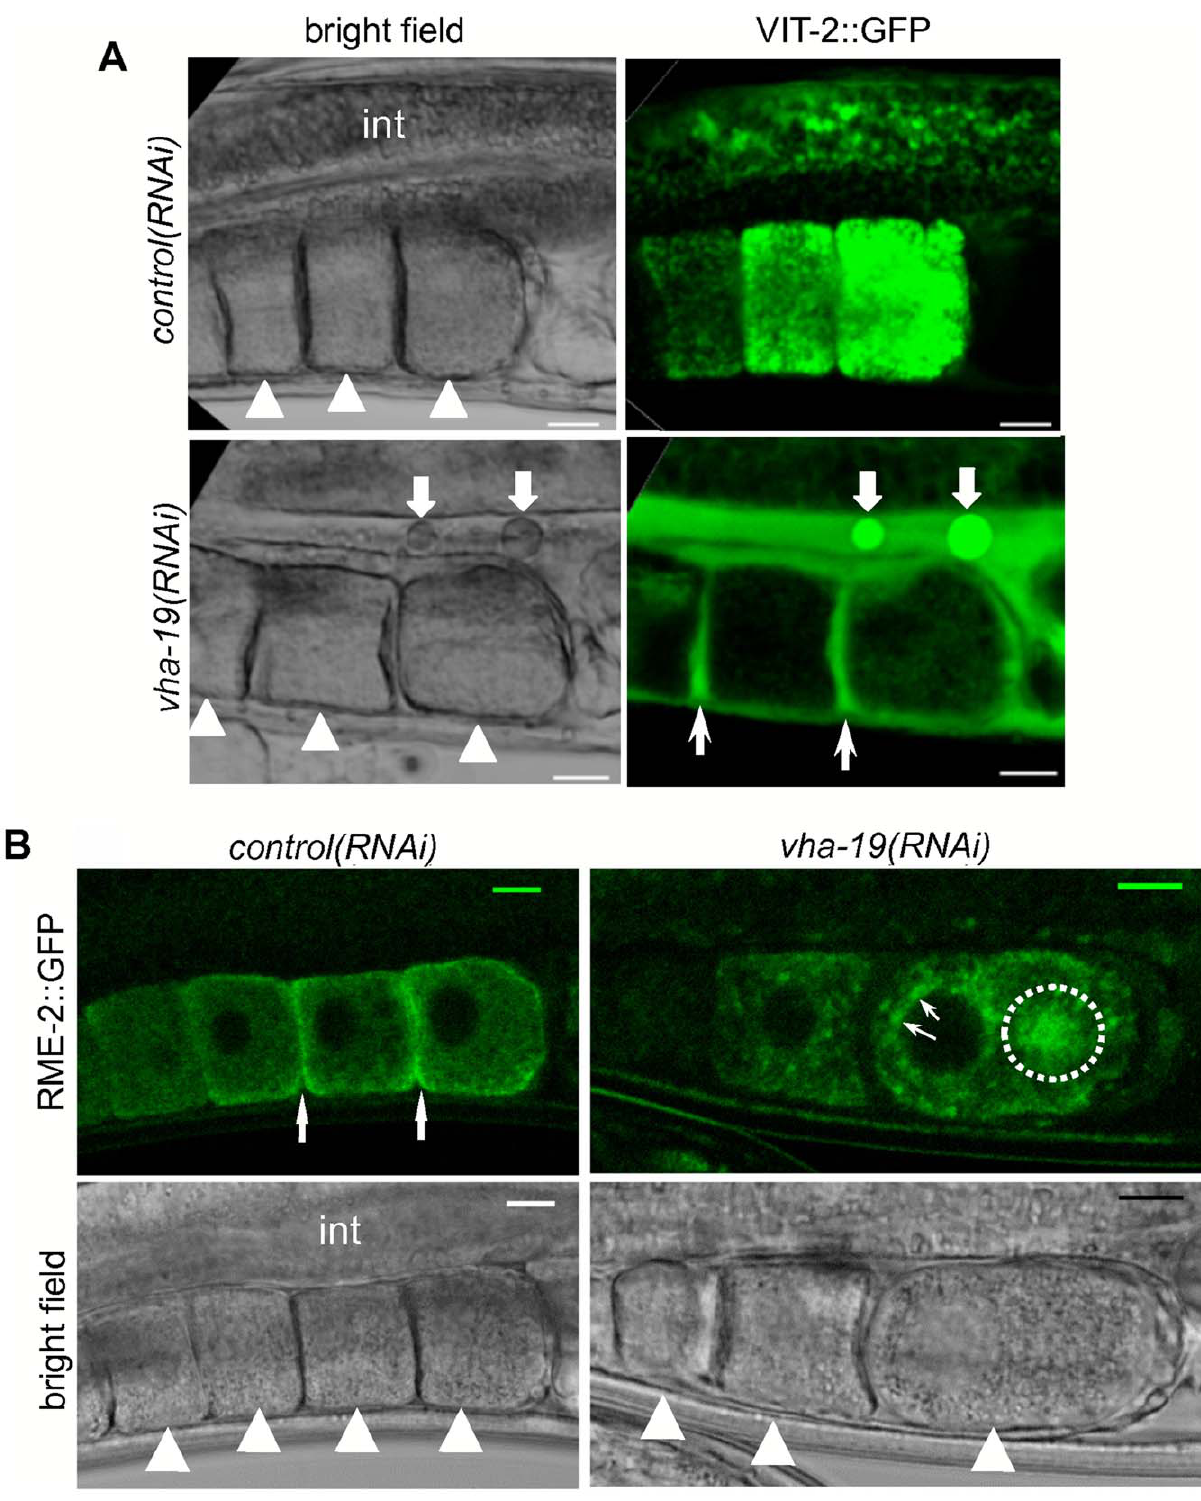
Figure 3. VHA-19 is required for uptake of vitellogenin via trafficking of the RME-2 receptor. A) VIT-2::GFP C. elegans [DH1033] were fed control or vha-19 dsRNA from the L4 stage for 48 hours and the oocytes examined. VIT-2::GFP did not reach the oocytes in adults fed vha-19 dsRNA, instead it accumulated between the oocytes (thin arrows). Fat arrows indicate agglomerates of VIT-2::GFP. B) RME-2::GFP was not trafficked to the plasma membrane in RME-2::GFP; vha-19(RNAi) adults (arrows and dotted circle), whereas RME-2::GFP did reach the plasma membrane in worms fed control dsRNA (thin arrows between oocytes). Worms were fed vha-19 or control dsRNA for 48 hours. Arrowheads in bright field panels indicate individual oocytes. Scale bars represent 10 m m.